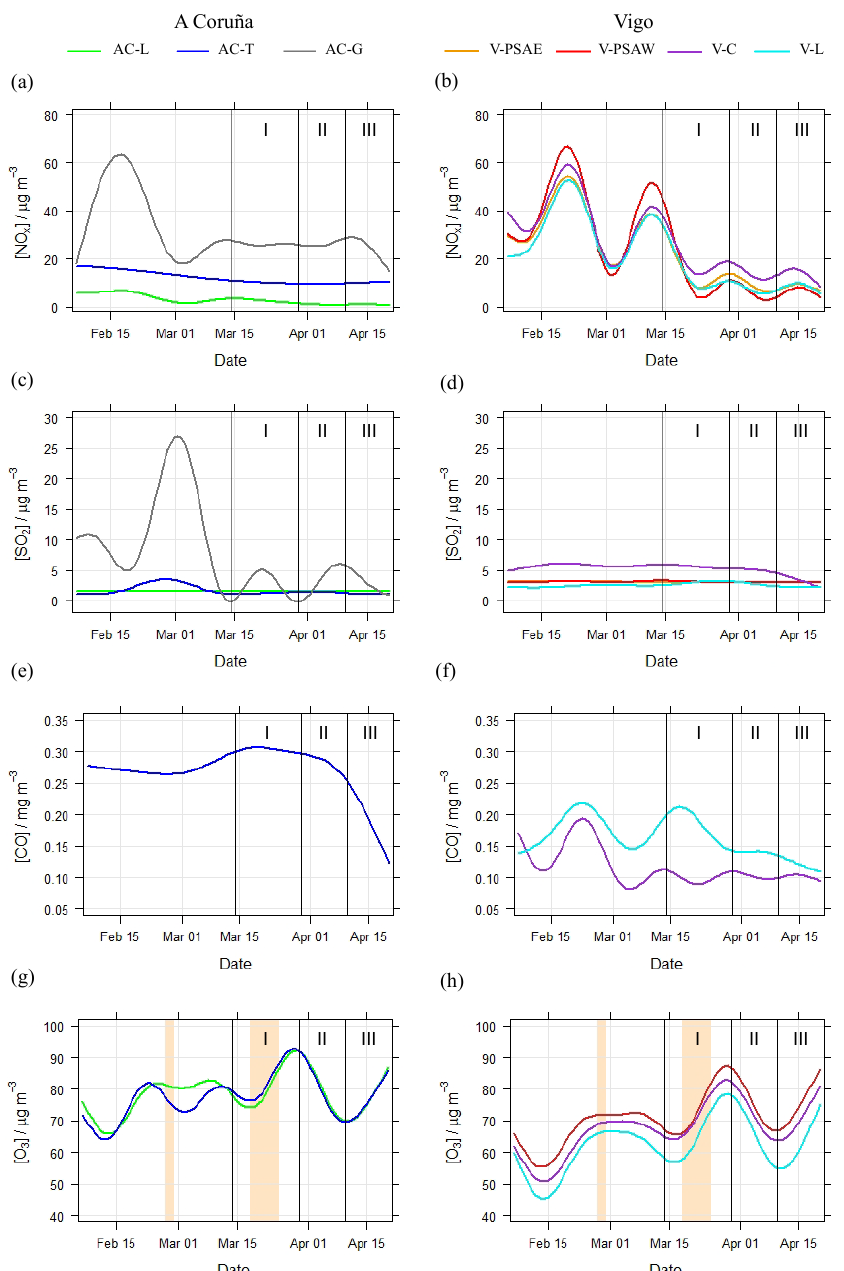
Figure 1. Concentration evolution of NO x ( a , b ) and SO 2 ( c , d ) (24 h mean), and CO ( e , f ) and O 3 ( g , h ) (maximum daily 8 h rolling mean) before and during the lockdown period. The left and right panels correspond to data obtained for air quality monitoring stations in the cities of A Coruña and Vigo, respectively. The areas highlighted in yellow show days with Saharan dust intrusion. The time periods of lockdown stages (I, II, and III) are also delimited by vertical black lines.